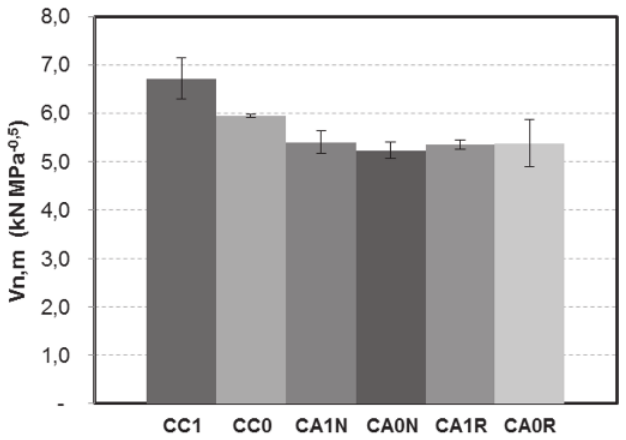
Figure 7 Mean and standard deviations values of the normalized ultimate shear load for all